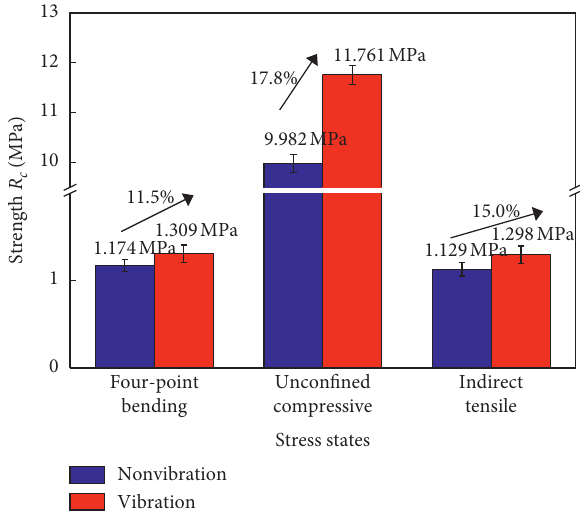
Figure 3: Standard strength of vibratory and nonvibratory mixed specimens under different stress